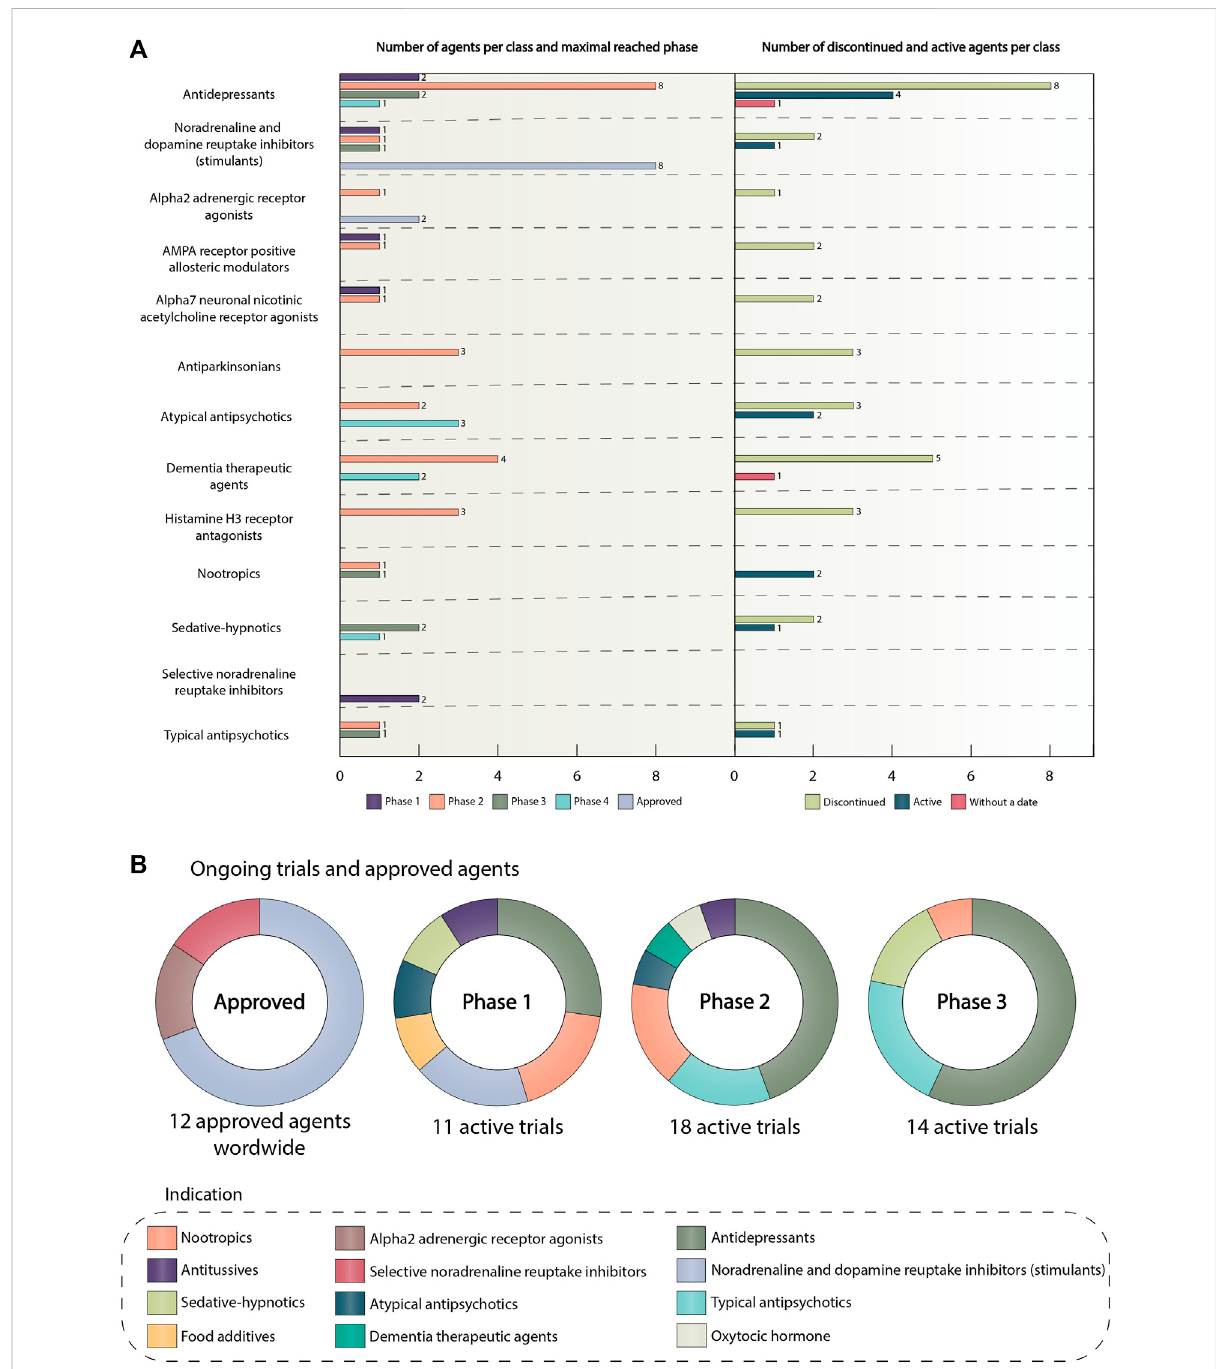
FIGURE 6 (A) Number of agents per category and maximal reached phase. The number of discontinued and active agents per category. This graph presents information about unique agents and their maximal reached phase in the following classes: antidepressants, central nervous system stimulants, alpha2 adrenergic receptor agonists, AMPA receptor positive allosteric modulators, alpha7 neuronal nicotinic acetylcholine receptor agonists, antiparkinsonian, atypical antipsychotics, dementia therapeutic agents, histamine H3 receptor antagonists, nootropics, sedative- hypnotics, selective noradrenaline reuptake inhibitors, typical antipsychotics. The colors of the bars show the maximal reached phase or approval status. The right side of the graph depicts the number of active or discontinued agents in the classes presented on the left side. The drug was classi fi ed as active if it was not approved and there were clinical trials on it after 2018. The drug was classi fi ed as discontinued if it was not approved, and there were no active clinical trials on it after 2018. If there was no completion date for the agent, it was placed in the “ without a date ” category. The length of the bars is proportional to the number of agents. The colors of the bars show the agent category. (B) Ongoing trials and approved agents The pie charts show the distribution of drug classes in ongoing clinical trials and among approved ADHD agents. The colors of the slices correspond to the pharmacological classes. Trials have been sub-categorized by phase. The data is due 4 January 2021. Abbreviations: ADHD, attention de fi cit hyperactivity disorder; α -amino-3-hydroxy-5-methyl-4-isoxazolepropionic acid receptor, AMPA